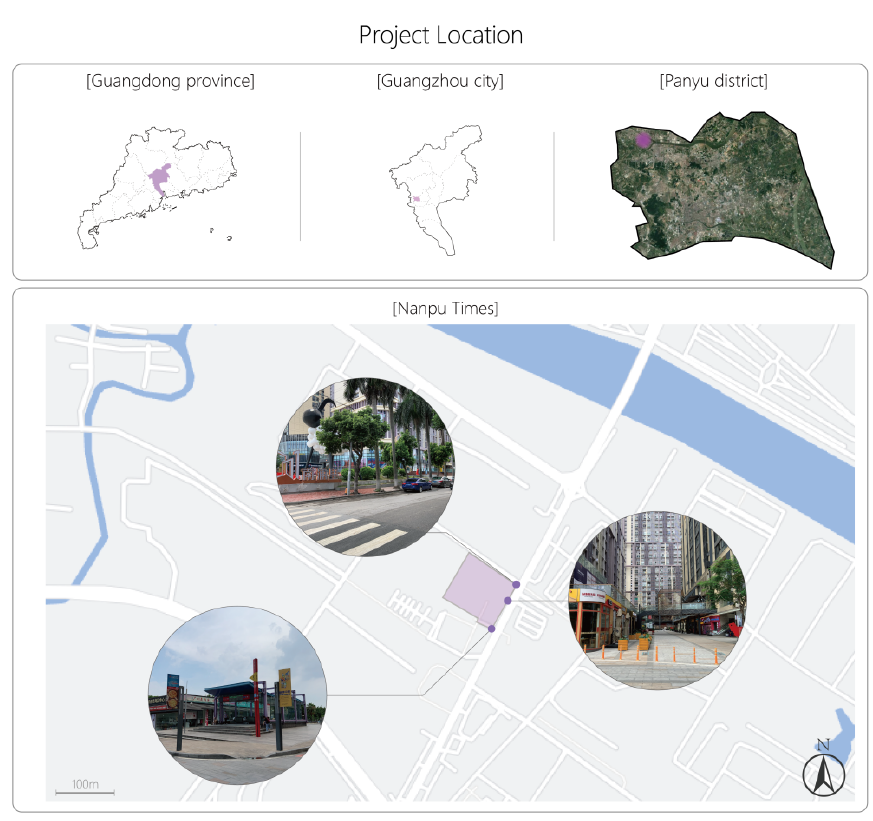
Figure 1. Nanpu Times project location.